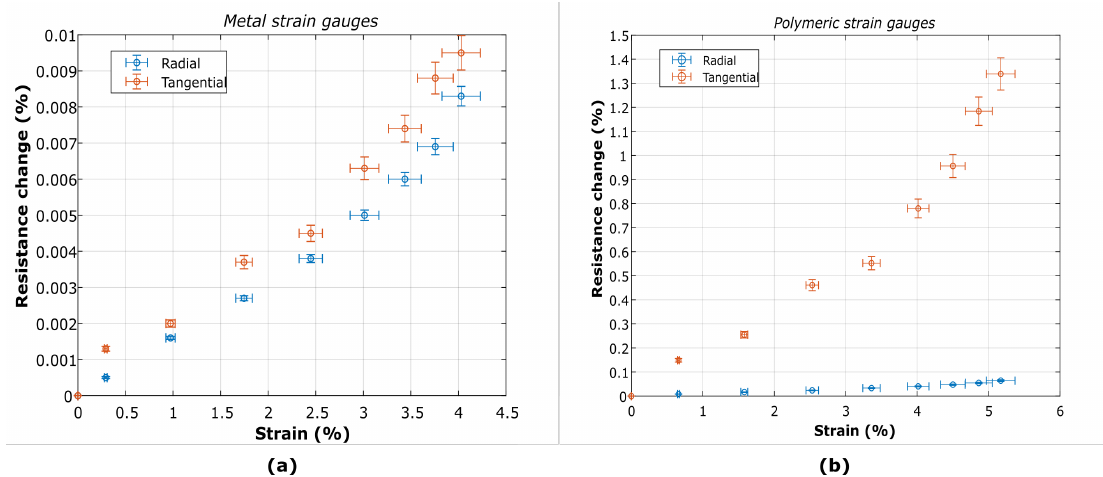
Figure 10. Resistance change as function of the strain on the membrane for radial and tangential strain gauges made of ( a ) titanium (Ti) and ( b )